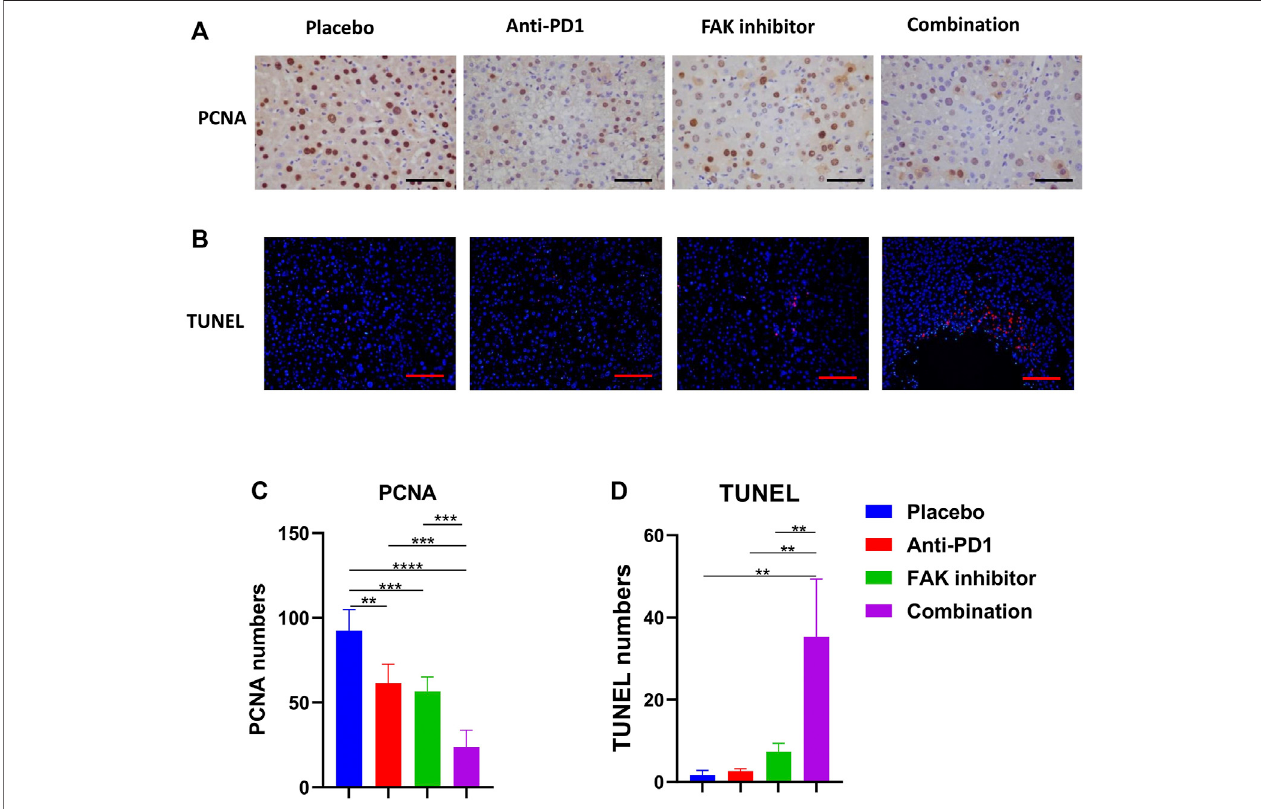
FIGURE 3 | Combination of FAK inhibition and anti-PD1 therapy inhibited proliferation and promoted apoptosis of HCC in mice (A) PCNA immunohistochemistry on HCCtissuesofmice(scalebars,100 μ m). (B) HCC tissues ofmiceineach groupwerestained withTUNEL-staining(scalebars,200 μ m). (C) Quanti fi cation ofPCNA staining ( n (cid:1) 5 mice/group). (D) Quanti fi cation of TUNEL staining ( n (cid:1) 3 mice/group). Signi fi cance identi fi cation: ns, p ≥ 0.05; *, p < 0.05; **, p < 0.01; ***, p <